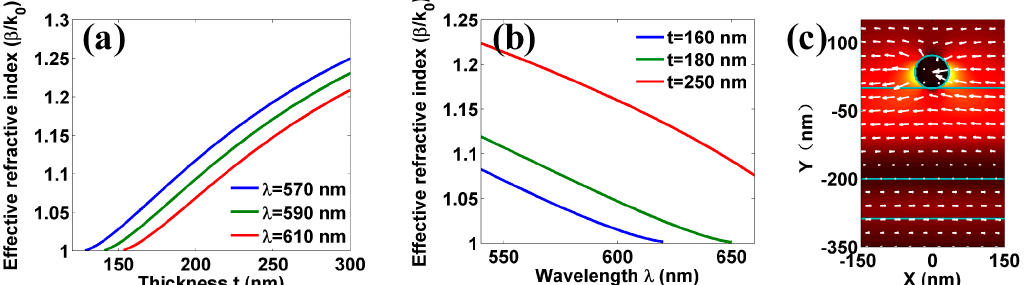
Figure 3. Simulated effective refractive index of the SPP waveguide mode. ( a ) The effective refractive index of Bloch surface wave mode versus the thickness of top SiO 2 layer, in the case of three selected incident wavelengths (570, 590, and 610 nm); ( b ) The effective refractive index of BSW mode versus the incident wavelength with three different thicknesses of top SiO 2 layer; ( c ) The electric field distribution of H1X mode with thickness t = 200 nm and wavelength λ = 590 nm. The arrows with white colour denote the directions of the electric fields, which shows that the mode is the H1X mode. The diameter of the Ag nanowire was 70 nm.